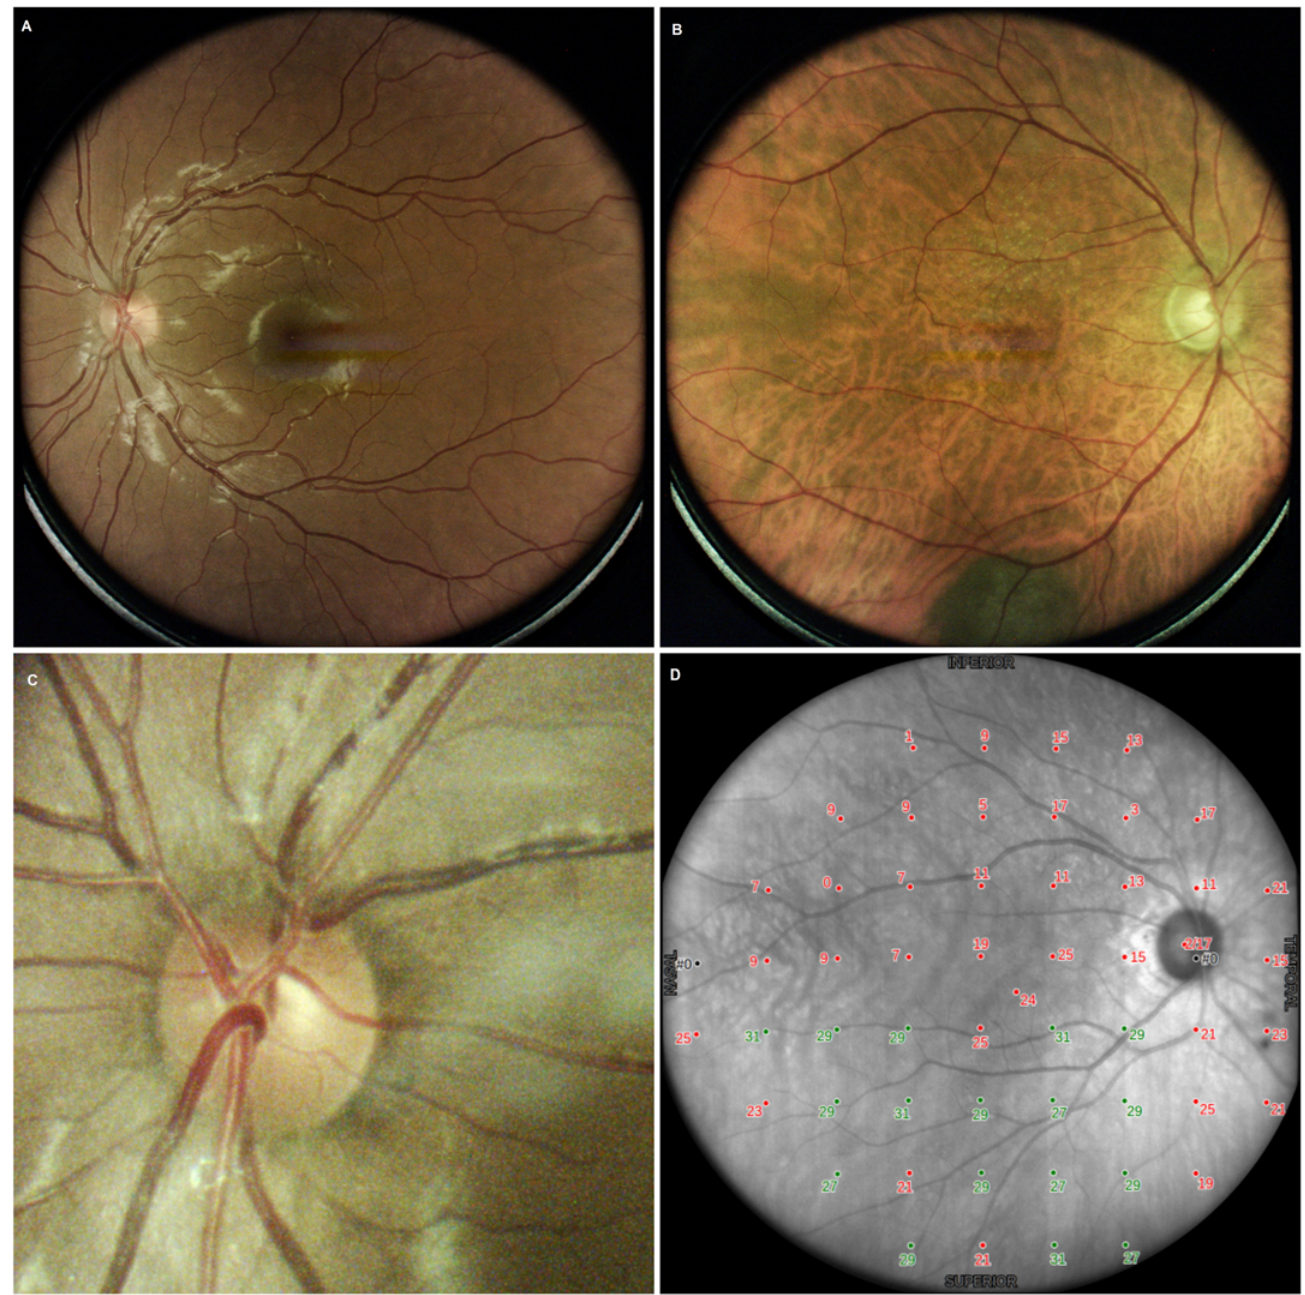
Fig 7. Examples of color images: normal subject (A), glaucoma patient (B), optic nerve head detail (C), infrared image with a sensitivity grid (D).